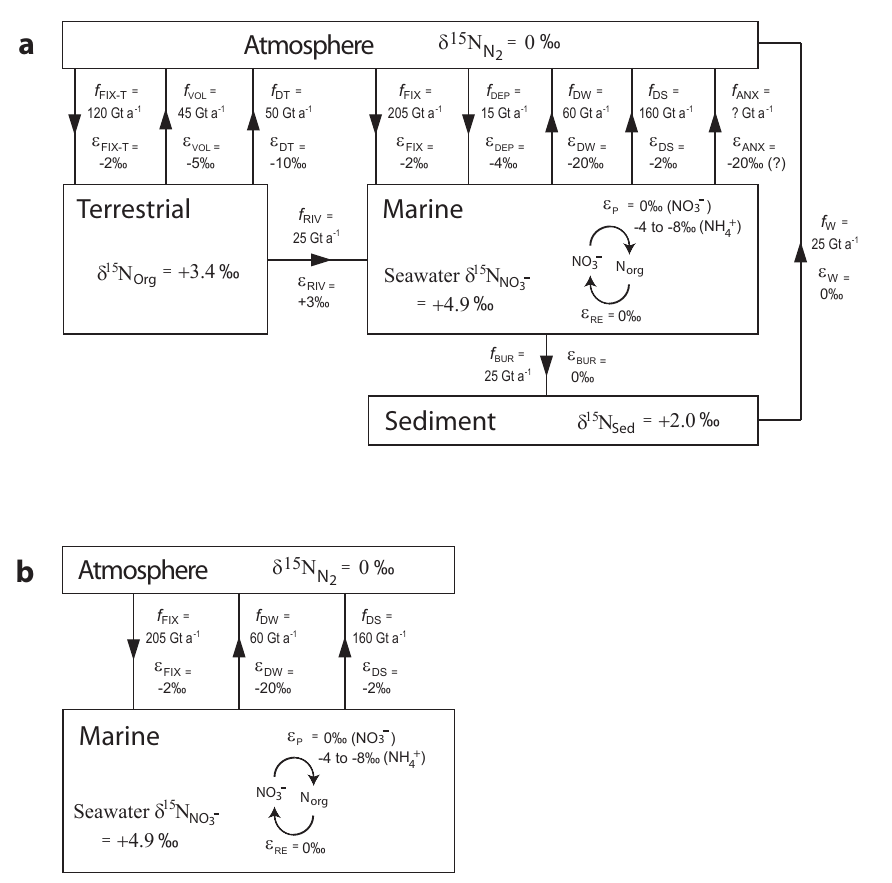
Fig. C1. Marine nitrogen cycle models. (a) Fully integrated marine–terrestrial–atmosphere N cycle. (b) Simplified N cycle model, which is limited to the most important source flux (cyanobacterial N fixation) and sink fluxes (sedimentary and water-column denitrification) of seawater fixed N. Fluxes ( f ) and fractionation factors ( ε) are shown for cyanobacterial fixation (FIX), soil volatilization (VOL), terrestrial denitrification (DT), riverine transport (RIV), atmospheric deposition (DEP), water-column denitrification (DW), sedimentary denitrification (DS), the anammox process (ANX), organic burial (BUR), sedimentary ammonification (AMM), and weathering (W). Sources of model parameters and discussion of model output are given in the